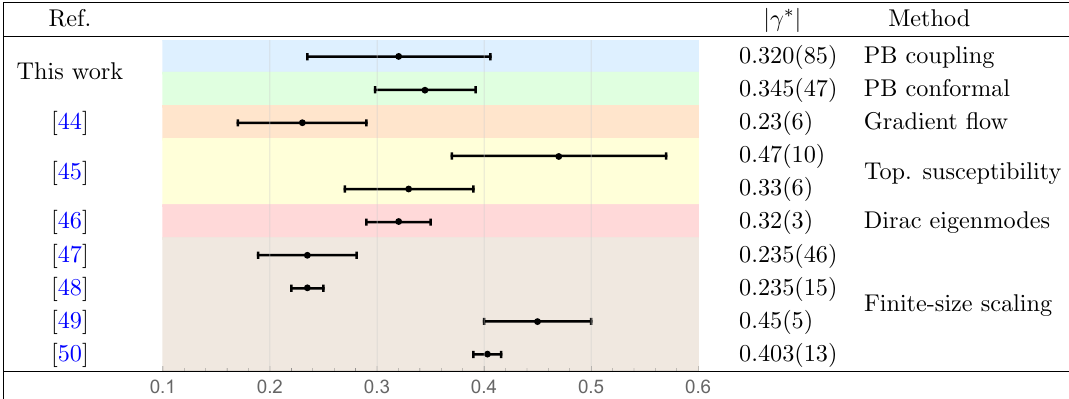
with the value where the central blue line in the n f = 11 panel of (cid:12)gure 7 crosses